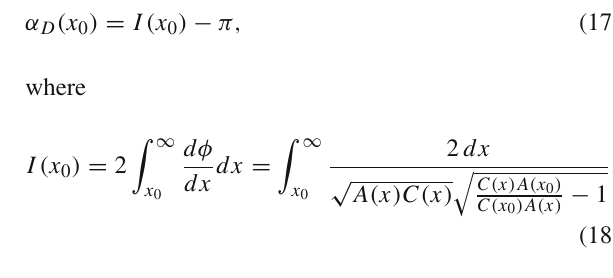
a photon sphere around the black hole. The radii of photon orbits for Charged black holes of 4 D EGB gravity decrease with increasing q and ˜ α (cf. Fig.